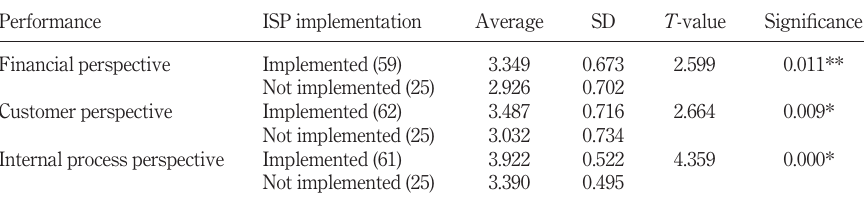
Table III. T -Test results for